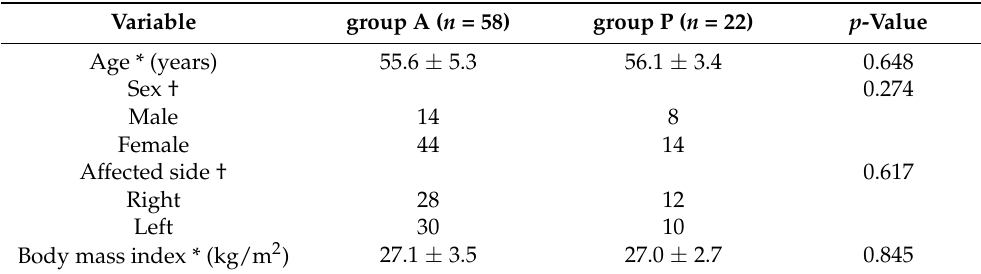
Table 1. Patient’s demographic data.